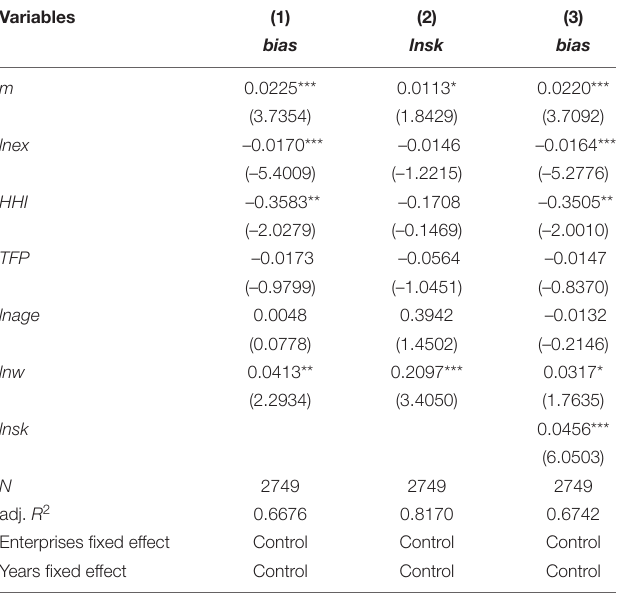
TABLE 9 | The results of mechanism